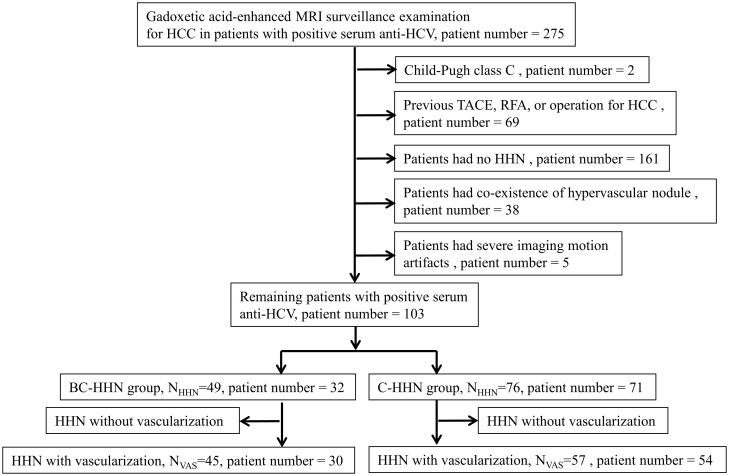
Flow chart for the selection of the study population.HCC, hepatocellular carcinoma; HHN, hypovascular hypointense nodule.